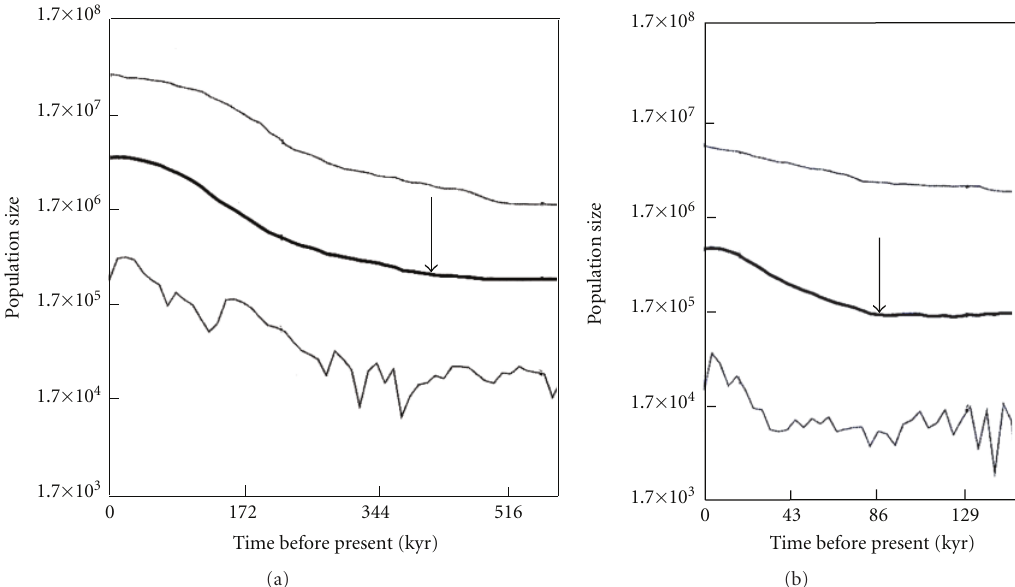
Figure 3: Bayesian skyline plots showing changes in e ff ective female population size ( N ef ) over time for Junonia genoveva from Costa Rica (a) and Guaymas, Mexico (b). Population size is given on a logarithmic scale. The thick solid lines represent the median estimates of population size; the thin solid lines show the 95% HPD (highest posterior density) intervals. Note the di ff erent time scales in the two plots. Arrows show estimated dates for the beginning of both population